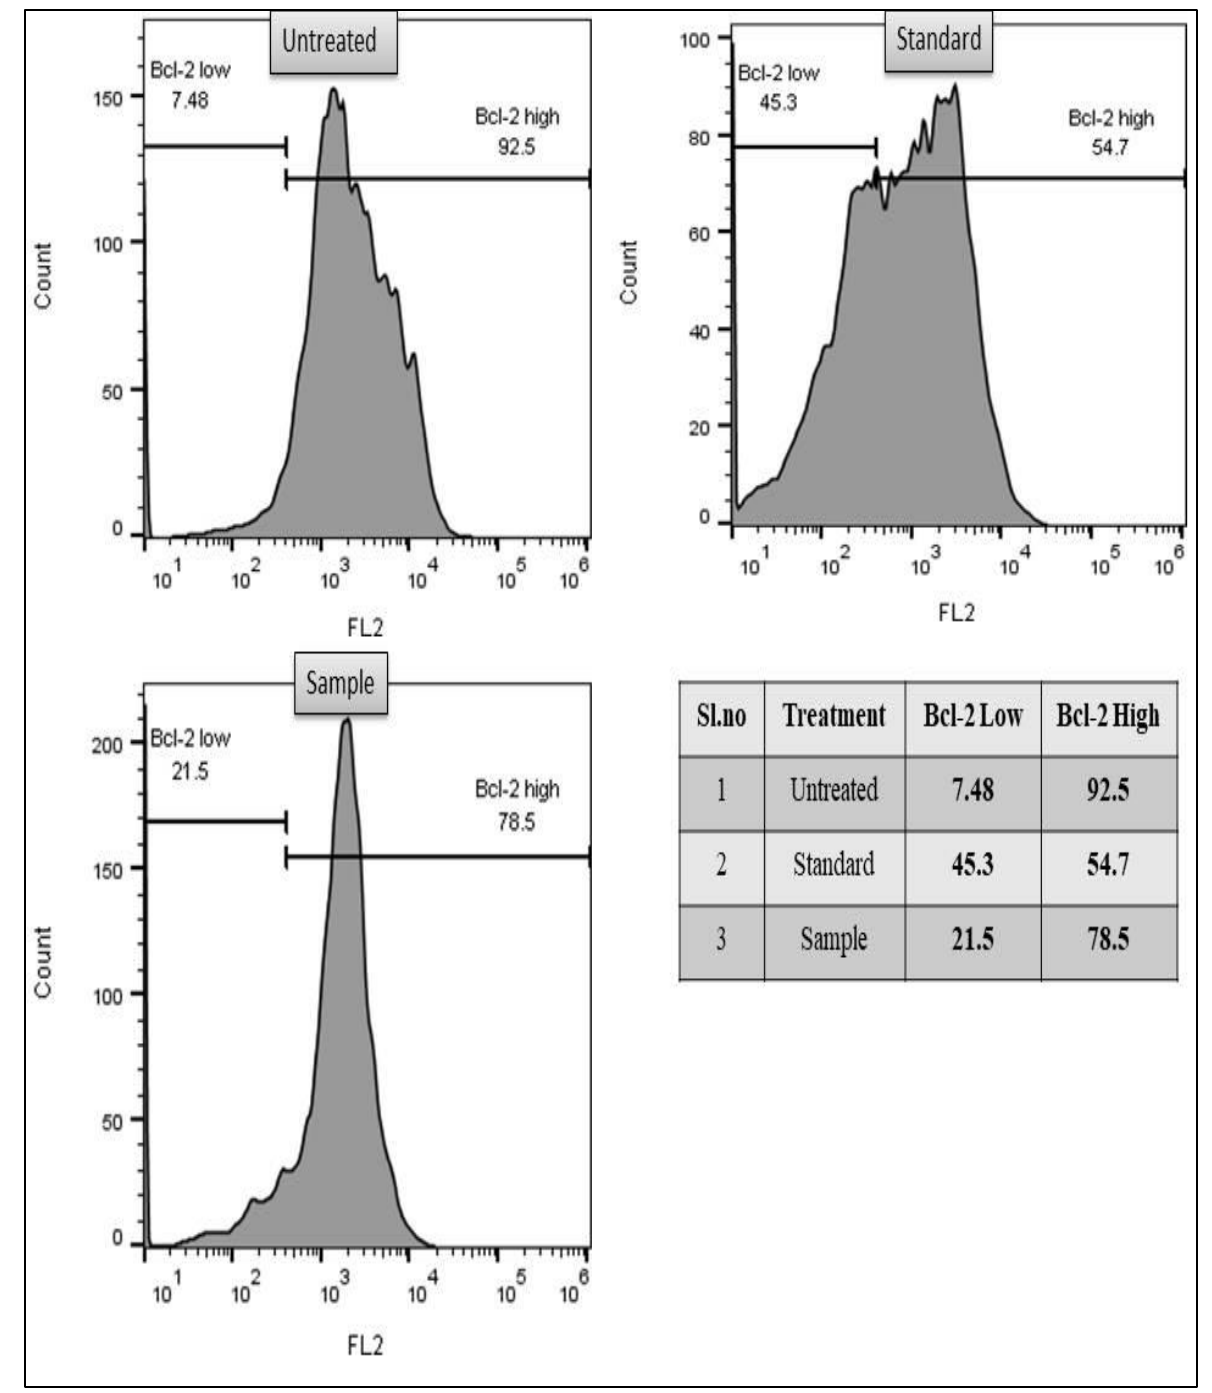
Figure 5. Flow cytometry-based study of inhibition of anti-apoptotic protein BCL-2 through methanol extract of C. colocynthis in the lung cancer A549 cell line.